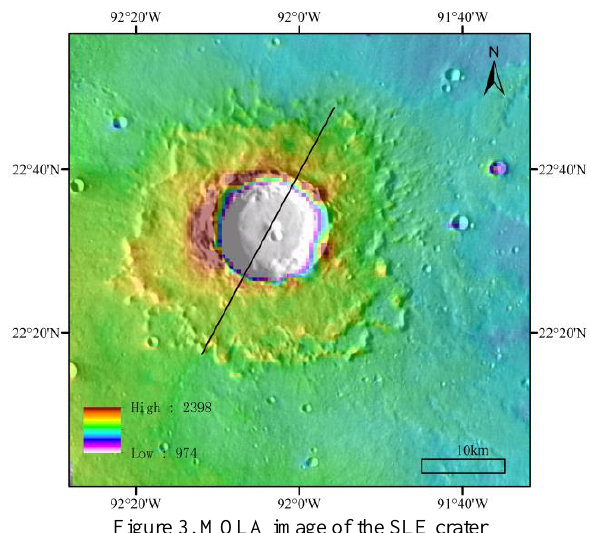
Figure 3. MOLA image of the SLE crater